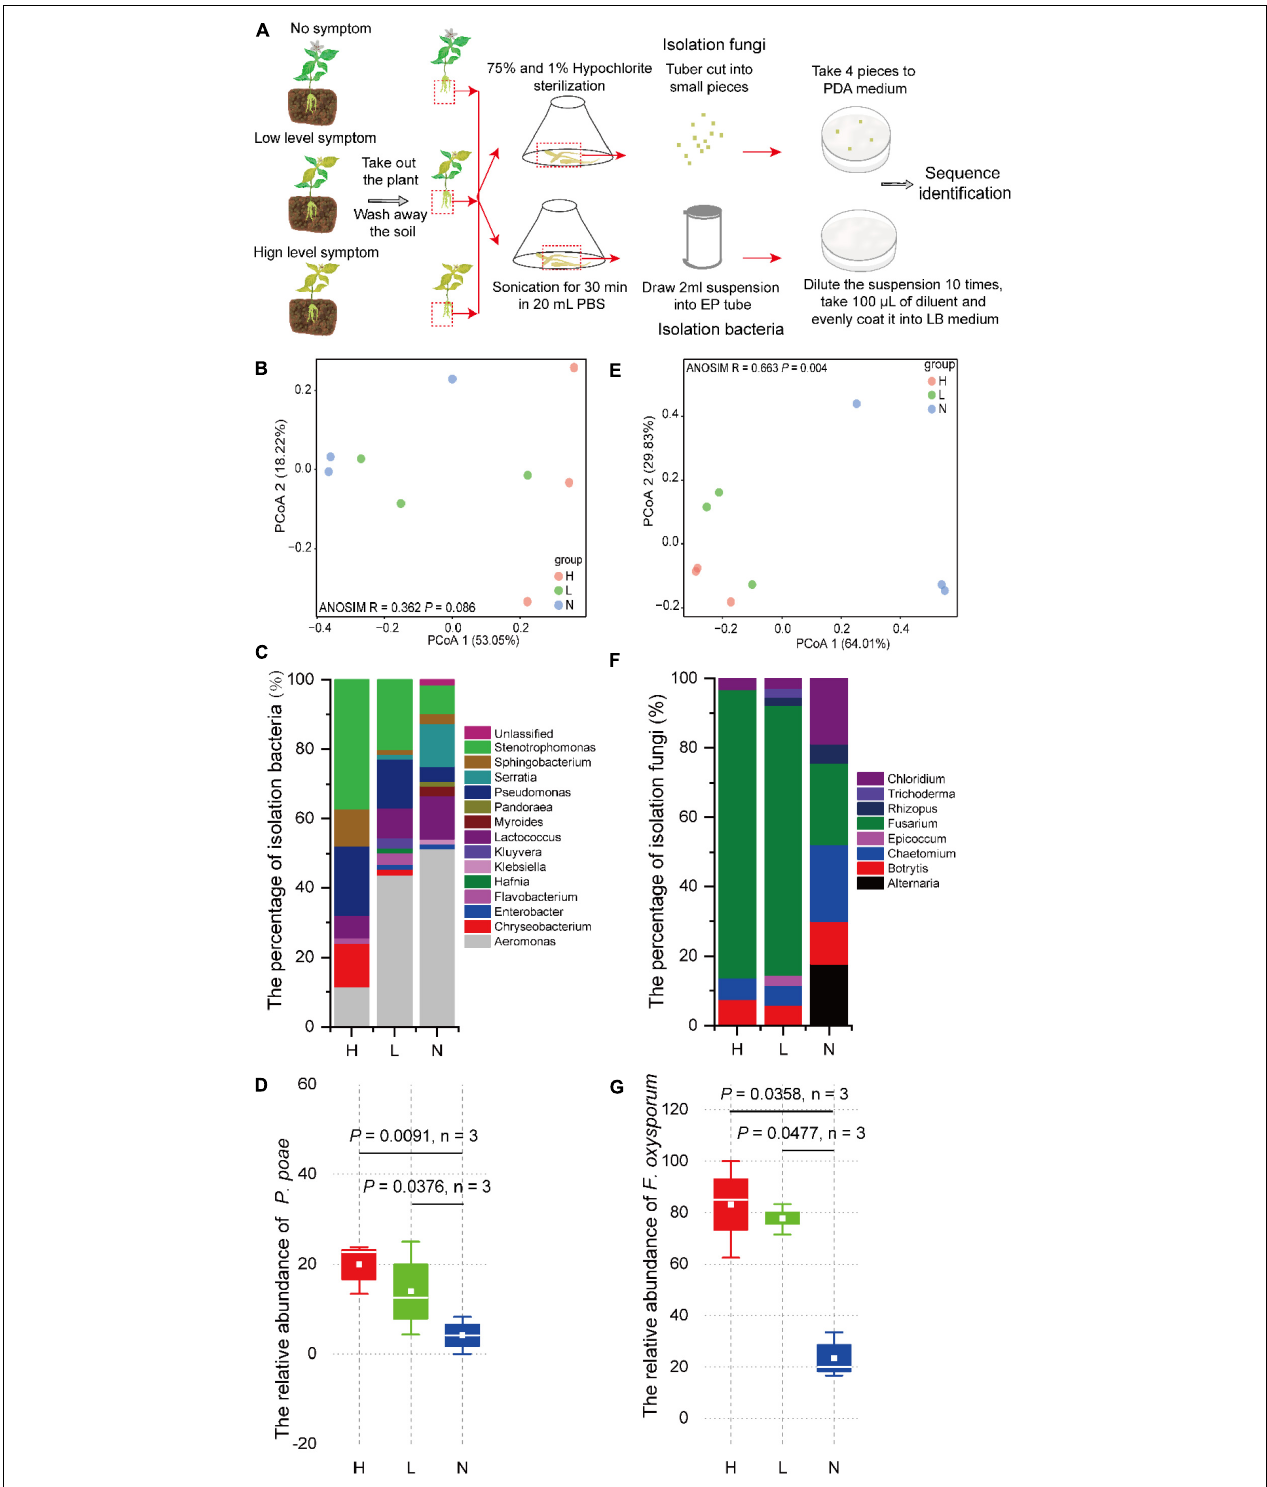
Frontiers in Microbiology |